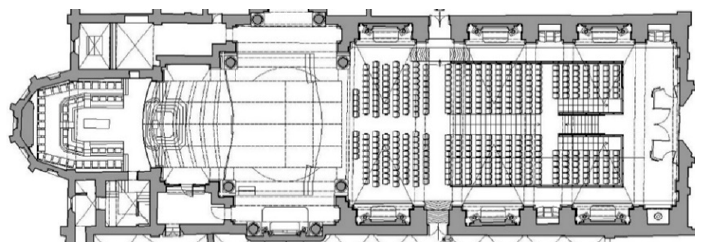
Figure 6. Proposal design of the sitting area in S. Dominic of Imola.